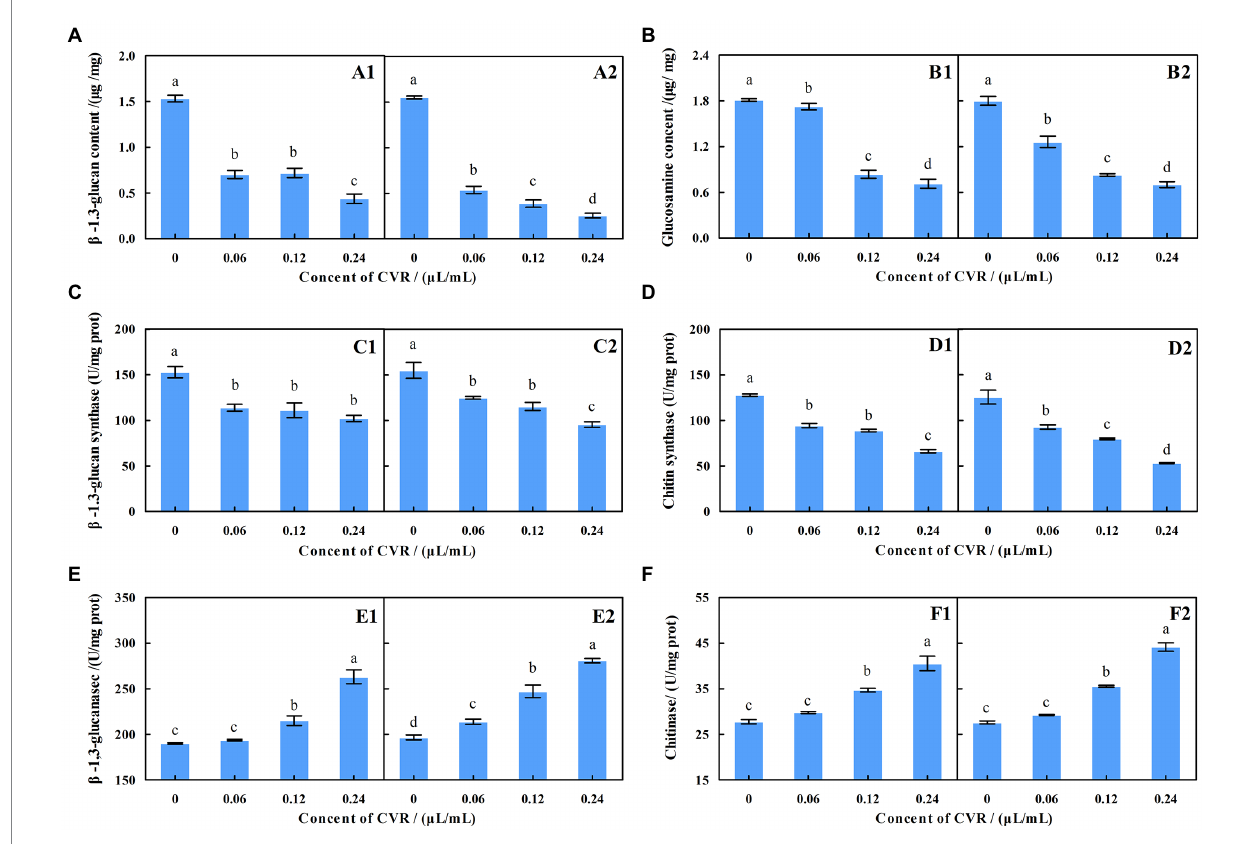
FIGURE 2 Effect of CVR on the content of β -1,3-glucan (A) in inside (A1) and outside (A2) , parts of mycelia, respectively; the content of chitin (B) in inside (B1) and outside (B2) parts of mycelia, respectively; the β -glucan synthase (C) activity in inside (C1) and outside (C2) parts of mycelia, respectively; the production of chitin synthase activity (D) in inside (D1) and outside (D2) parts of mycelia, respectively; the production of β -1,3-glucanase activity (E) in inside (E1) and outside (E2) parts of mycelia, respectively; and the production of chitinase activity (F) in inside (F1) and outside (F2) parts of mycelia, respectively. Different letters represent significant differences at the level of p <